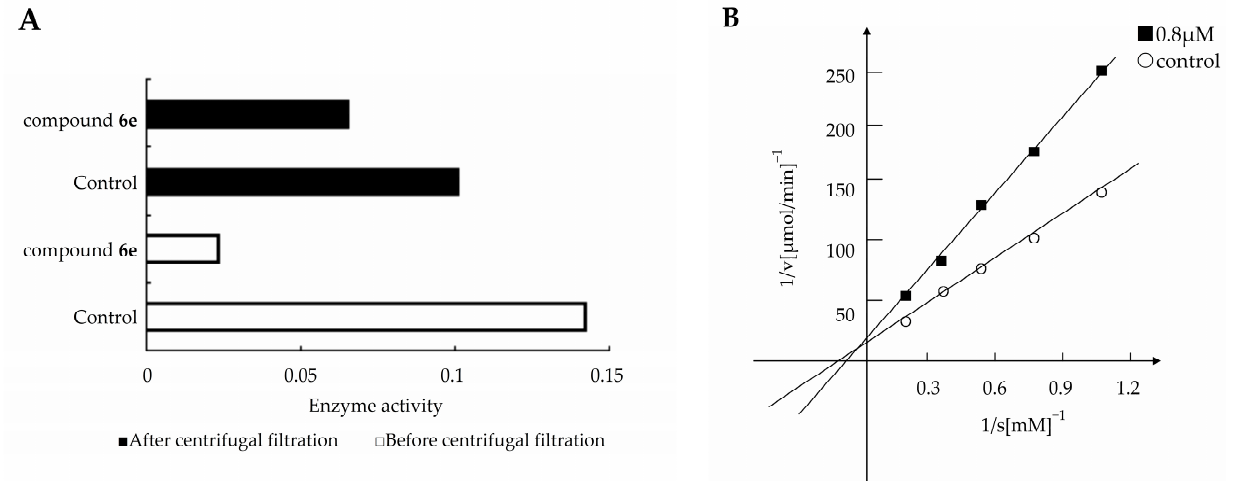
Figure 5. ( A ) Recovery of enzymatic activity by elimination of 6e by centrifugal filtration. ( B ) Lin ‐ eweaver–Burk plots of α ‐ glucosidase without ( ○ ) and with ( ■ ) 6e .